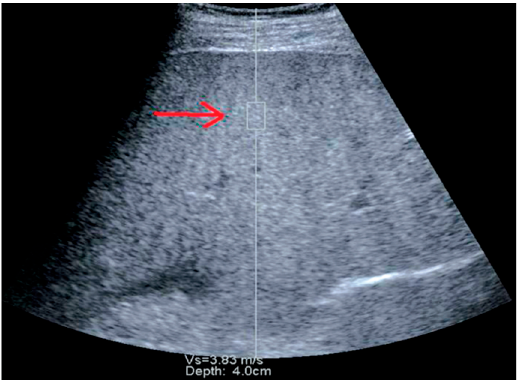
Figure 2. Point shear wave elastography (pSWE) using Siemens equipment. The “red arrow” is pointing to the region of interest